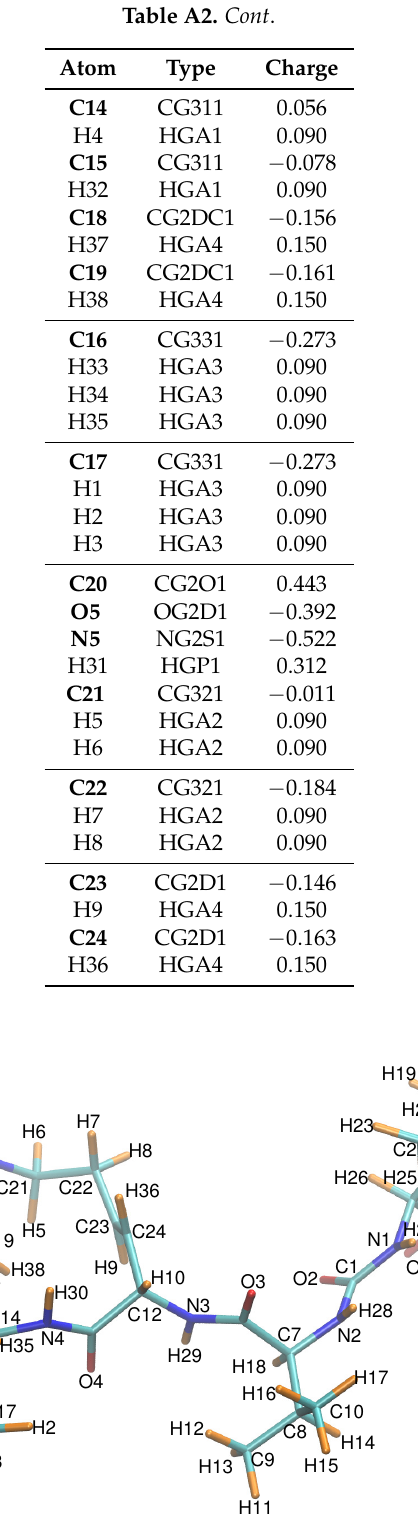
Figure A1. SylA is depicted with each atom labeled according to the numbering scheme of Table A2. Carbons are shown in cyan, oxygens in red, nitrogens in blue, and hydrogens in orange. Note that atom numbering here was only relevant for the charge parametrization procedure and differs from that of, e.g., Ref. [6]; C 18 corresponds to C 4